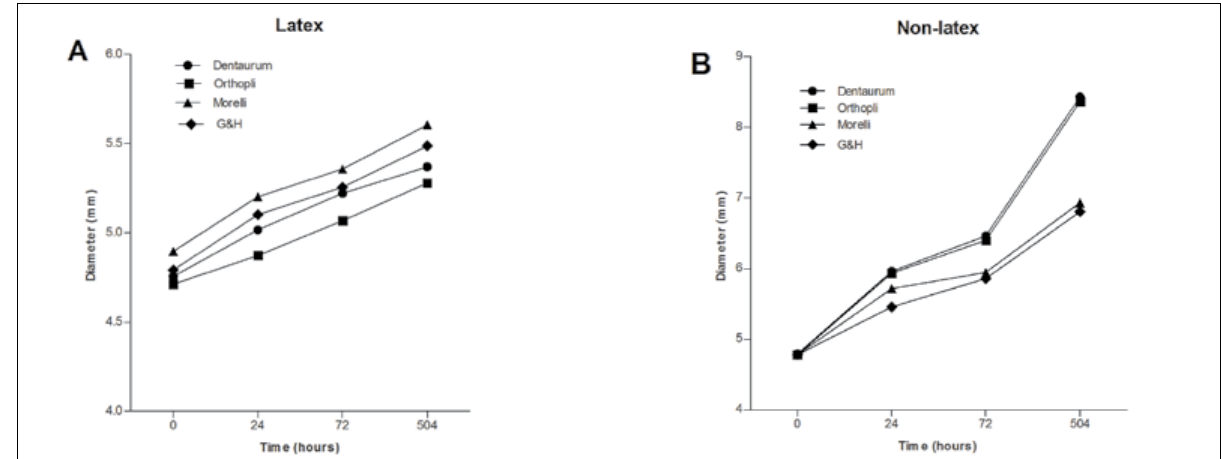
Figure 7. Comparison of the internal diameter of the latex (A) and the non-latex (B) elastics: Dentaurum, Orthopli, Morelli and G&H, in all experimental periods. p <0.05.